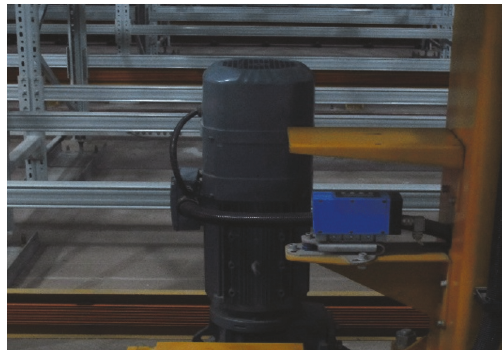
Figure 9: Basic structure of stacker running